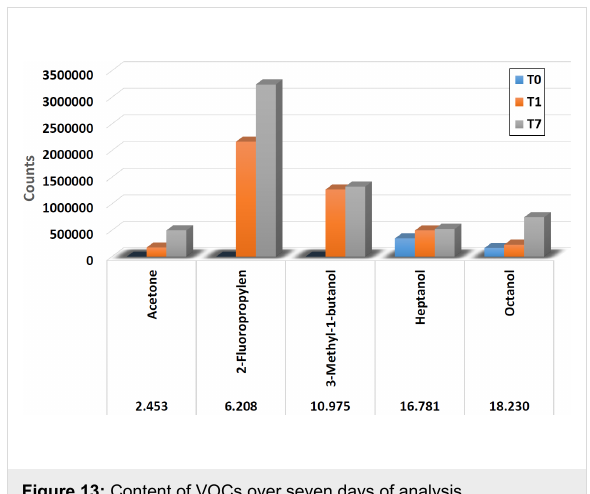
Figure 13: Content of VOCs over seven days of